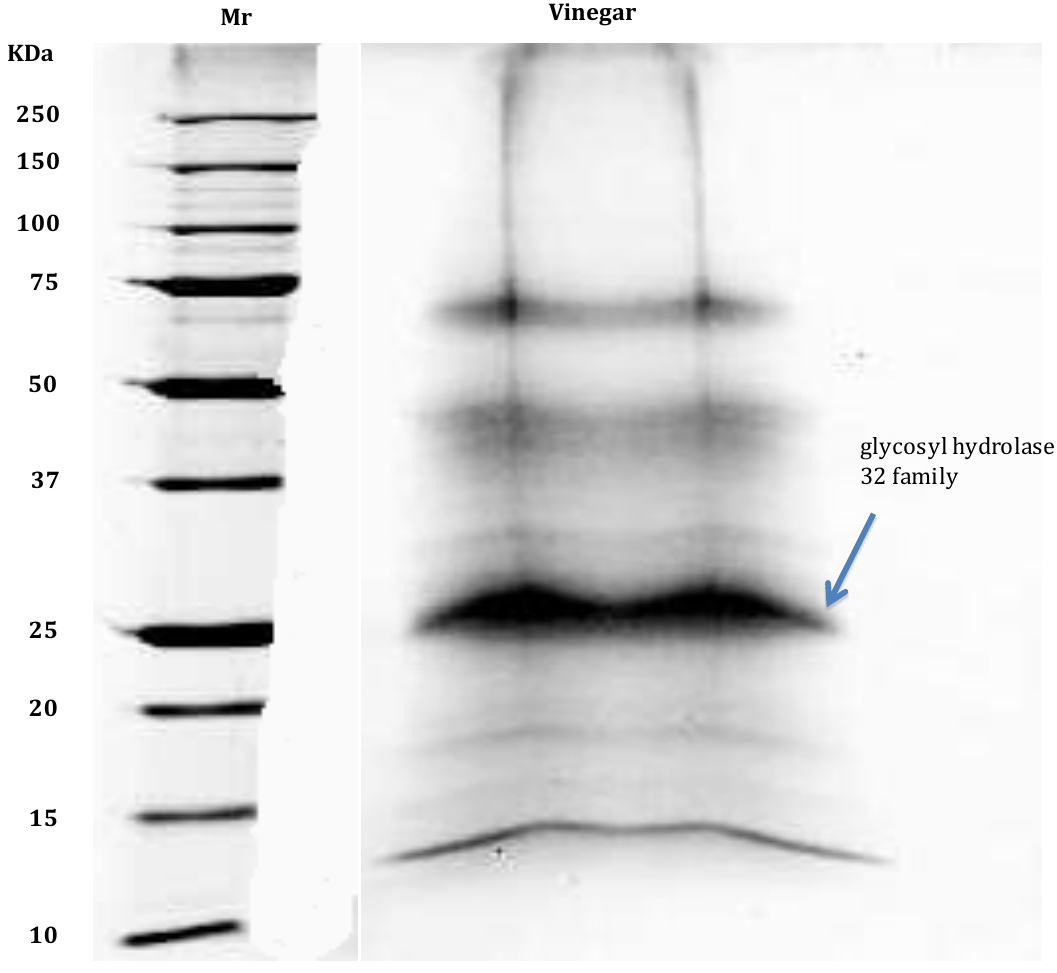
Figure 4. SDS-PAGE of white-vine vinegar. Mr: molecular mass ladder. Laemmli discontinuous buffer. Gel: 8%–18% polyacrylamide gradient. Run: three hours at 300 V. Sample load: 25 µL containing ca. 50 µg protein. Staining with micellar Coomassie Brilliant Blue. The major protein (the whole genome shotgun sequence of line PN40024, scaffold_22, a protein belonging to the glycosyl hydrolase 32 family) is indicated with an arrow (modified from Di Girolamo et al.